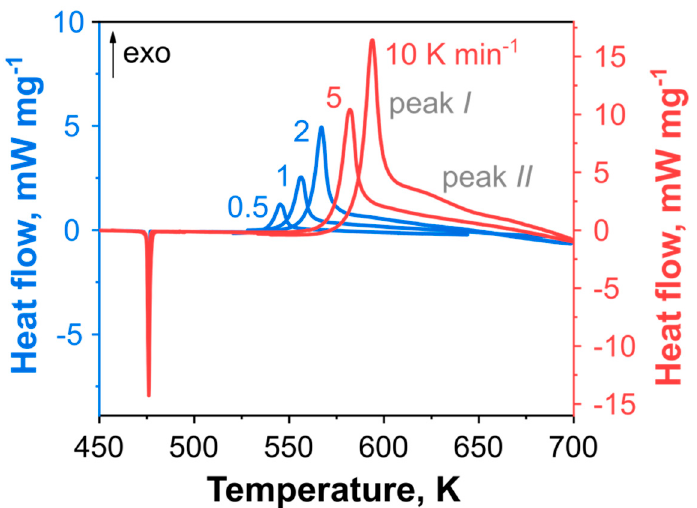
Figure 3. The DSC traces for linearly heated DBT at an elevated pressure of 2.0 MPa. Note the different Y-scale for low- and high-heating rate data.